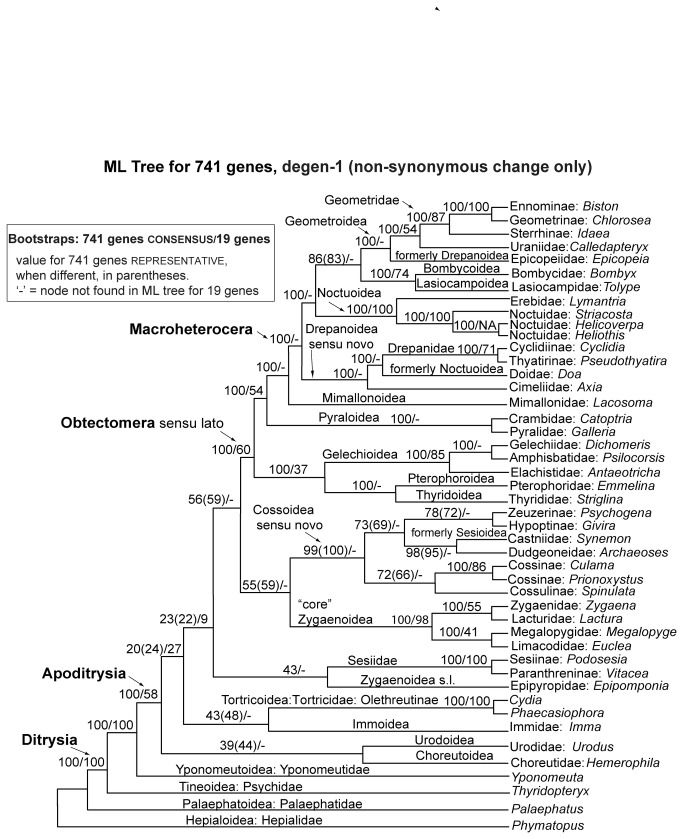
ML tree for 46 taxa, 741 paralogy-filtered genes, degen-1 (non-synonymous change only).Bootstrap percentages: 741 genes consensus method, followed by 741 genes Rrepresentative method in parentheses but only when these two differ, followed by 19 genes, each based on 1000 bootstrap replicates with 5 search replicates each. ‘-’ = node not found in ML tree for 19 genes.